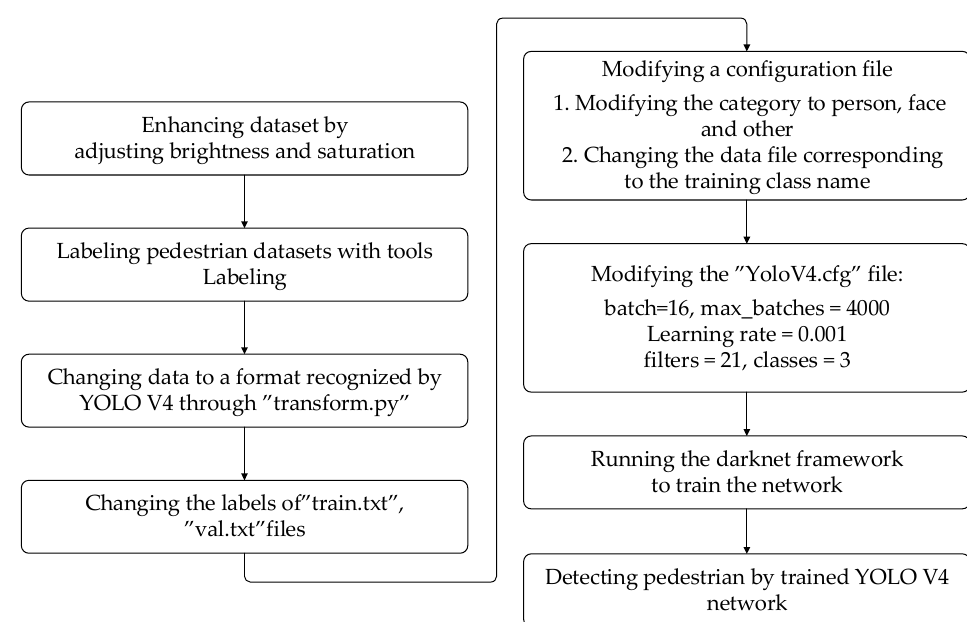
Figure 3. Flow chart of training YOLO V4 network and face detection.